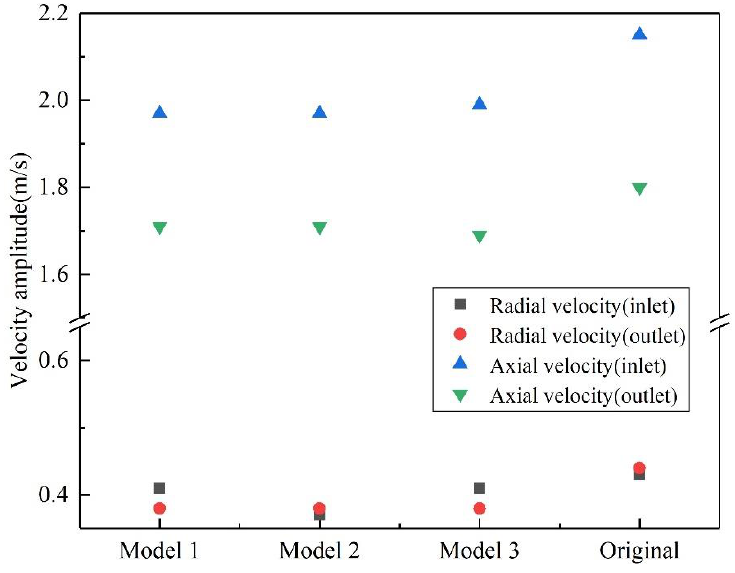
Figure 5. Inlet and outlet speed